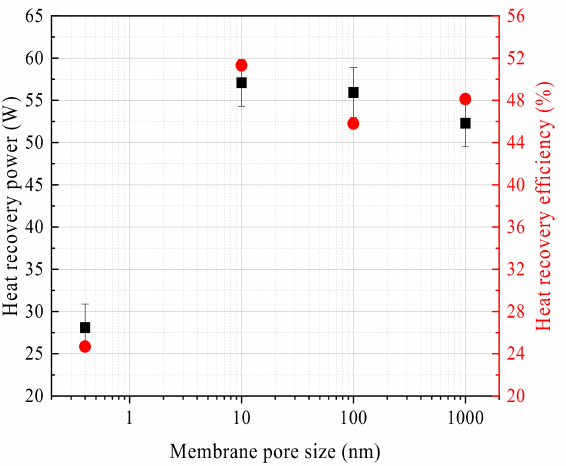
Figure 18. Heat recovery power/efficiency vs. membrane pore size. Experiment conditions: flue gas inlet temperature 56.27 ◦ C, flue gas flow 10.58 L/min, negative pressure airflow 0